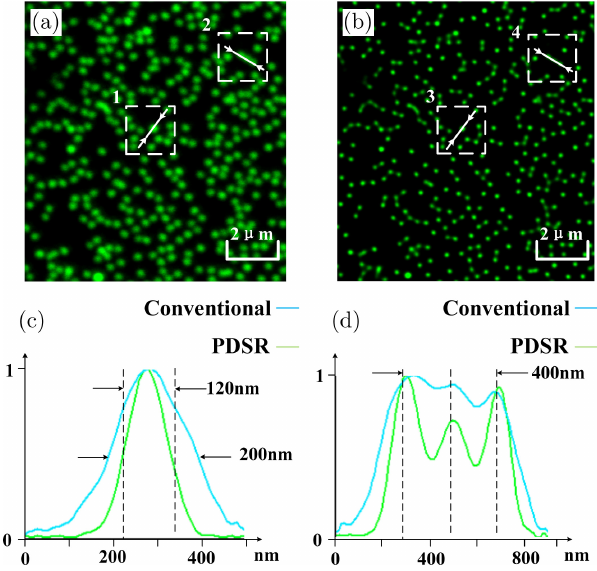
Fig. 3. Resolution enhancement realized by PDSR microsco- py. The diameter of °uorescence bead is 100 nm. (a) The image captured by conventional confocal laser scanning microscopy. (b) The image captured by PDSR microscopy. (c) The nor- malized line pro¯les of the single °uorescence bead along the traces indicated by white line in the Nos. 1 and Nos. 3 dashed box region. (d) The normalized line pro¯les of °uorescence beads along the traces indicated by white line in the Nos. 2 and Nos. 4 dashed box region. Scale bar: 2 (cid:1)